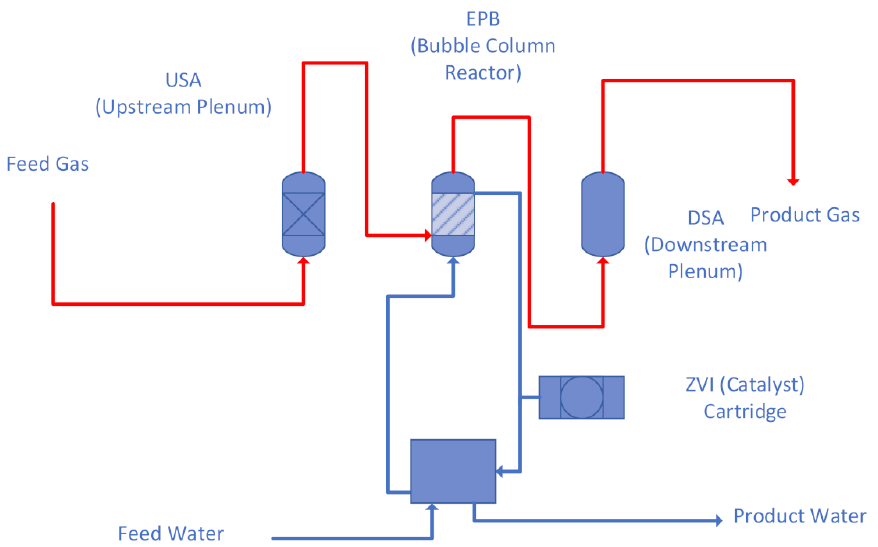
Figure 2. Gas management, oscillating flow structure adopted in the reactor. The bubble column used in this study acts as an EPB. The EPB discharges product water to a recycle tank and receives feed water from the recycle tank (Figure 1).